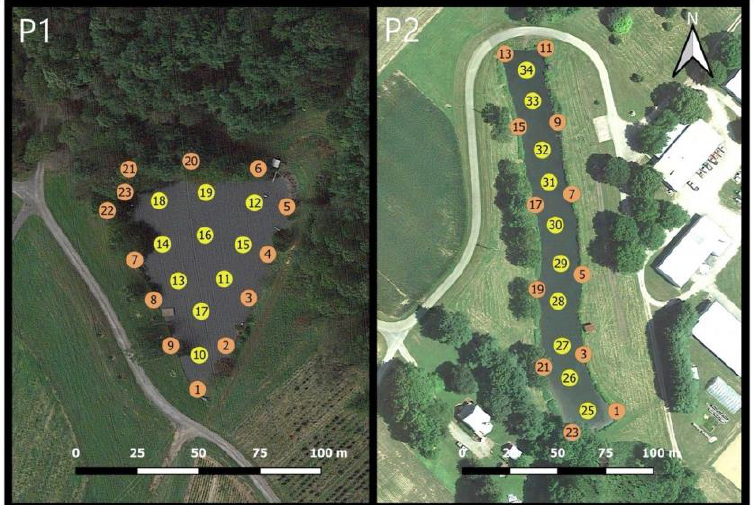
Figure 1. Sampling locations for both Pond 1 (P1) and Pond 2 (P2). Sampling location number is shown inside the circle. Yellow circles indicate interior water sampling locations and orange circles indicate nearshore sampling locations.